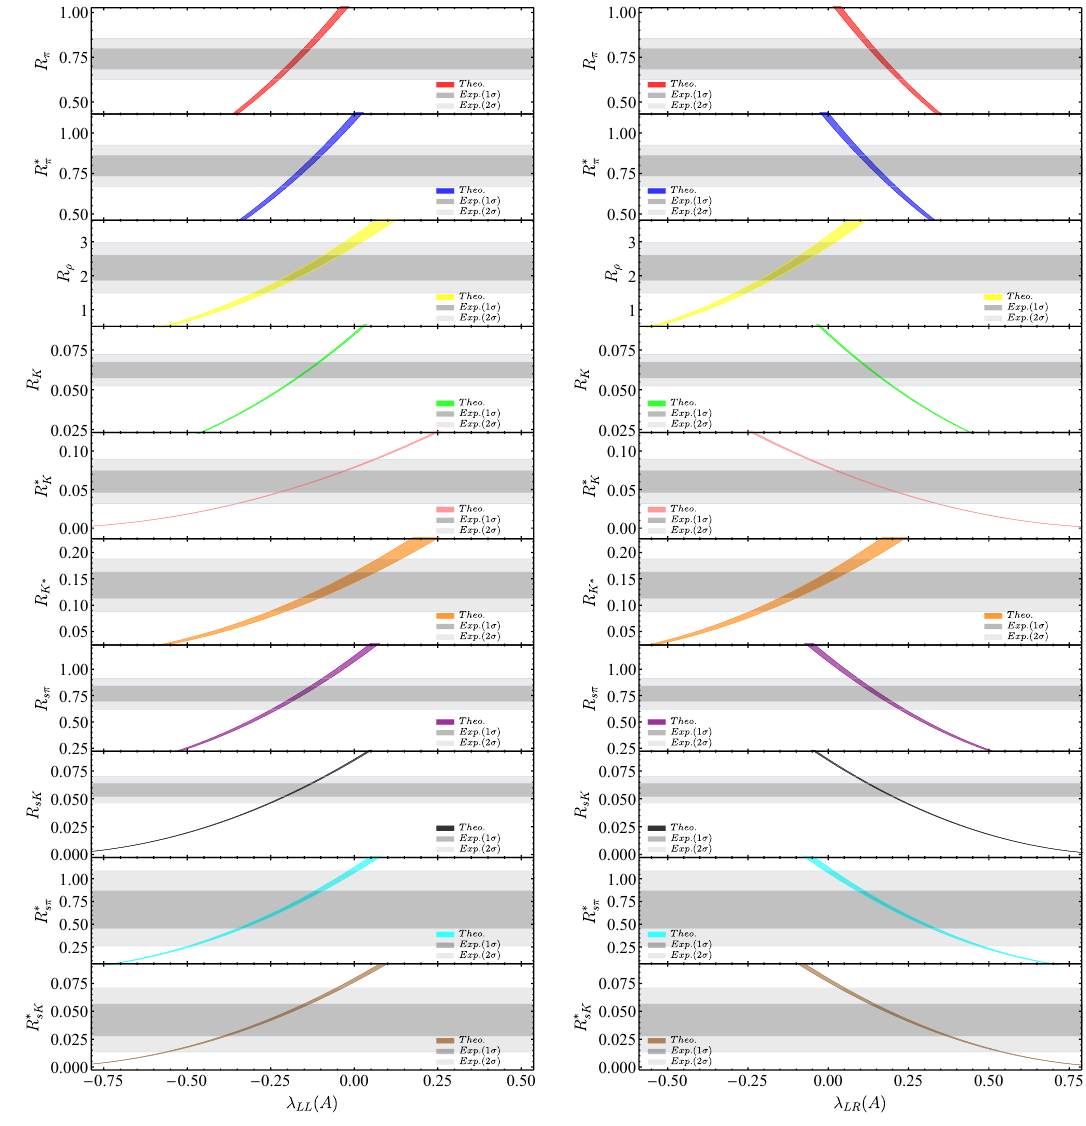
Figure 15 . Constraints on the effective coefficients λ LL ( A ) (left) and λ LR ( A ) (right) from the ratios R ( ∗ ) collected in table 6. The other captions are the same as in figure ( s ) L